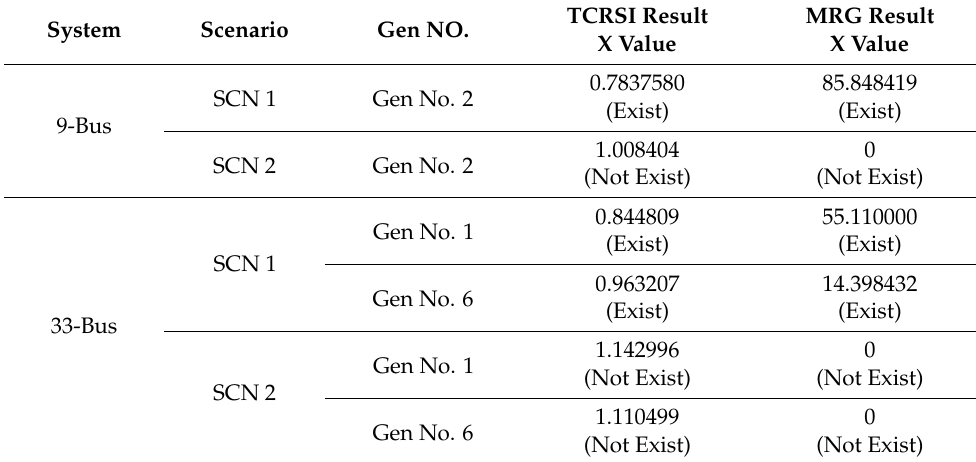
Table 1. Scenarios introduction on both systems.